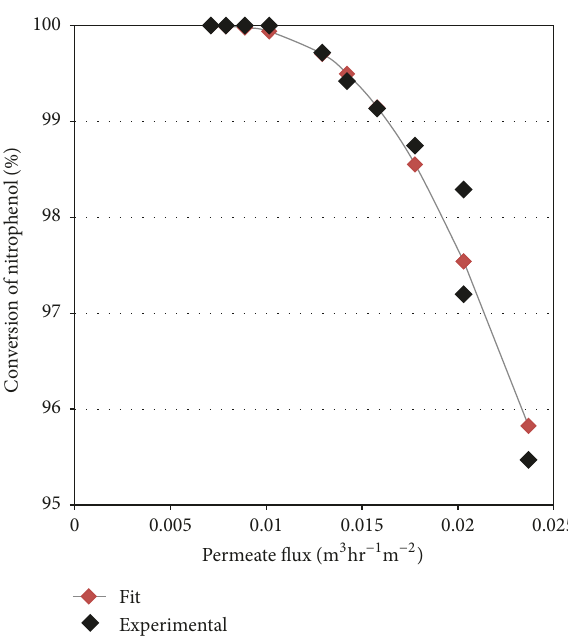
Figure 7: Plot of 𝑝 -NP conversion versus flux. The curve (with red diamond) represents a first-order reaction model with a rate constant ( 𝐾 app ) of 300 hr −1 . Feed conditions: [ 𝑝 -nitrophenol] = 0.514 mM, [NaBH 4 ] = 14.38 mM, Pd = 0.733 mg, and catalytic layer = 0.198 𝜇 m.